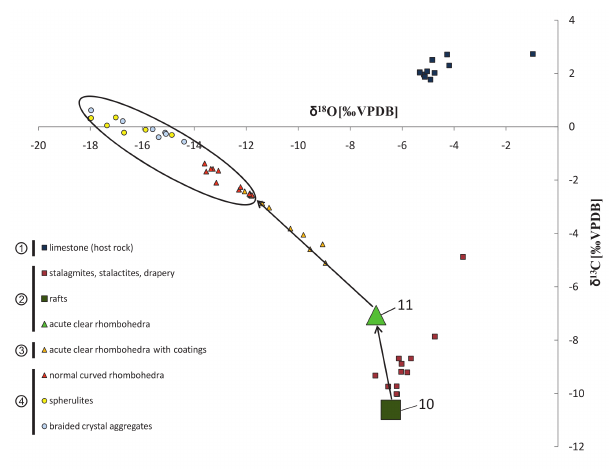
Fig. 7. Carbon and oxygen isotopic composition of various cal- cite particles from the R¨atselhalle in comparison to those measured from calcitic host rock samples (1) and common calcites of stalag- mites, stalactites and draperies (2). (3) acute clear rhombohedra overgrown by cryogenic cave calcites, (4) cryogenic cave calcites. Numbers represent amount of samples measured.